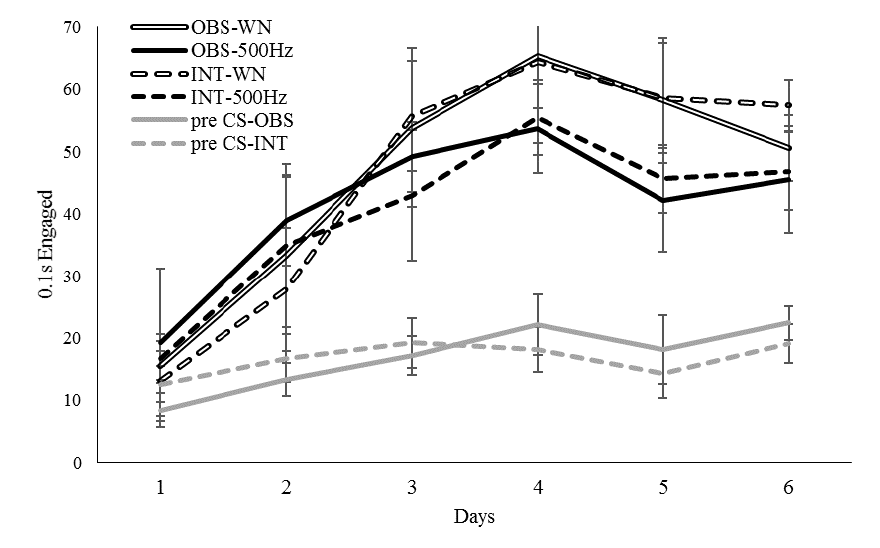
Figure 2. Nosing of the food trough in 10-second periods immediately prior to CS presentation (pre CS), and during both CSs (white noise and 500Hz tone) for intervened upon stimuli (INT) and response-independent stimuli (OBS) in Experiment 2. Error bars indicate